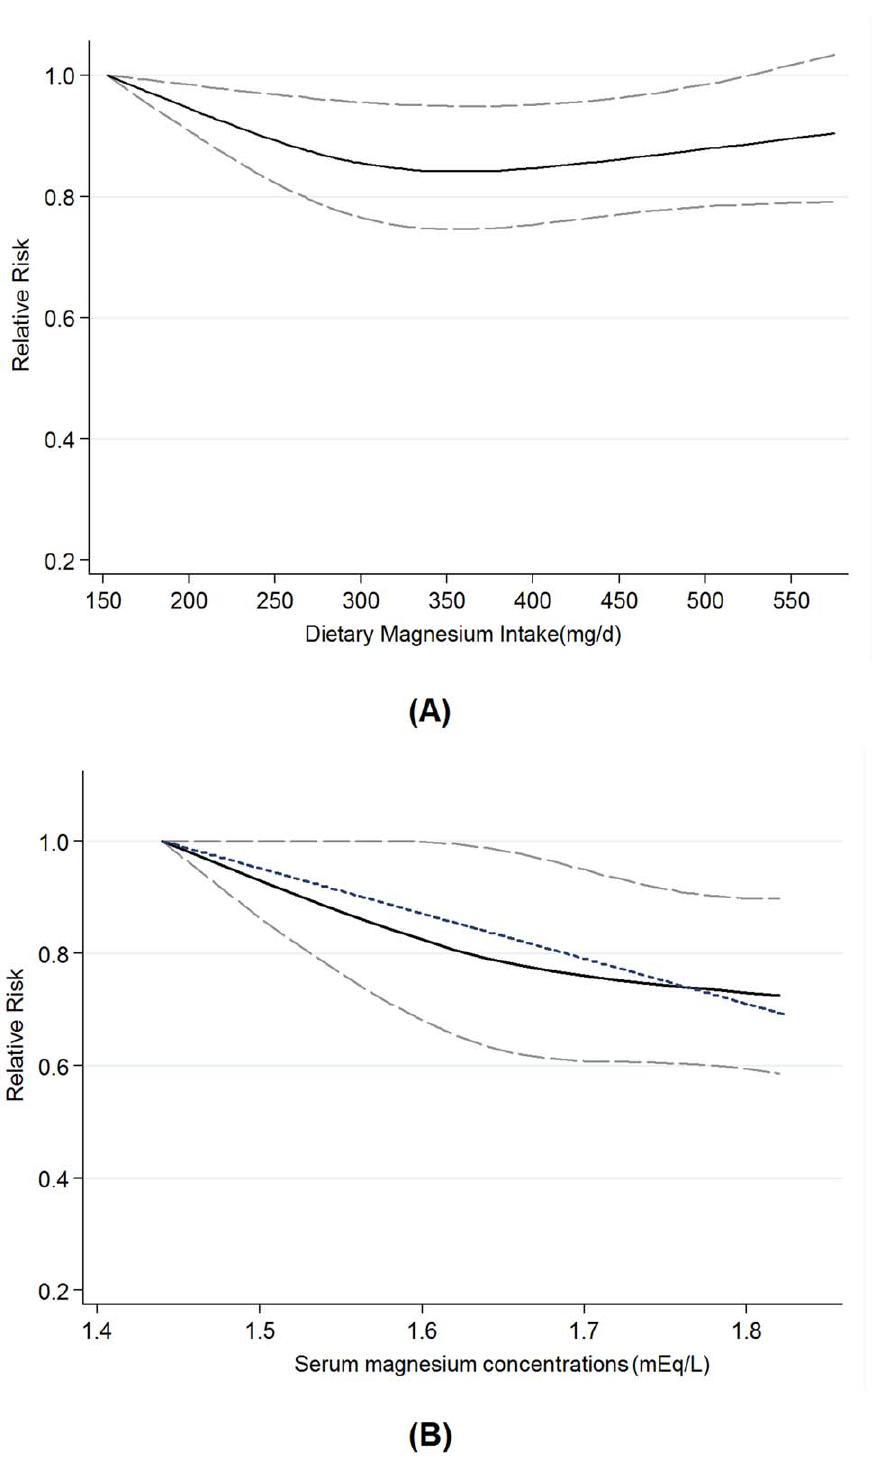
Figure 2. Dose-response relationship between dietary magnesium intake and serum magnesium concentrations and the risk of total CVD events. Relative risk (solid line) with 95% confidence interval (long dashed lines) for the association of dietary magnesium intake and serum magnesium concentrations with risk of total CVD events in a restricted cubic spline random-effects meta-analysis. The short dashed line represents the simpler linear model. The lowest values of 152 mg/d of dietary magnesium and 1.44 mEq/L of serum magnesium were used to re- estimate all relative risks.